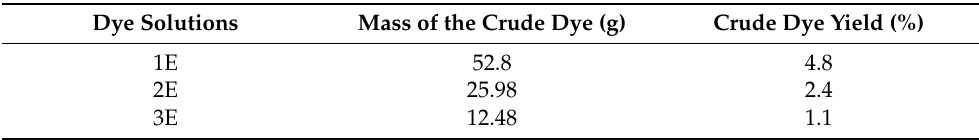
Table 2. Crude dye yield in the investigated dye